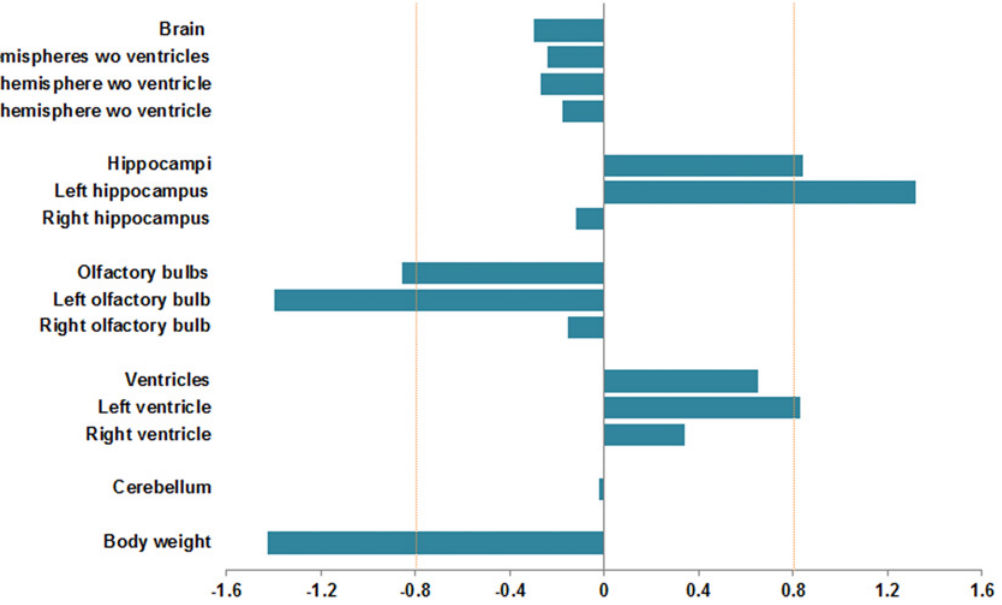
Fig 5. Effect of ethanol exposure on brain regional volumes obtained from MRI images, and body weight. Cohen´s d was calculated to study the effect size between controls and ethanol-exposed adult male offspring (P60). Large effect size was considered when d values were (cid:3) 0.8 (increase in volume) or (cid:4) -0.8 (decrease in volume) after ethanol exposure (dashed line on d = ± 0.8).